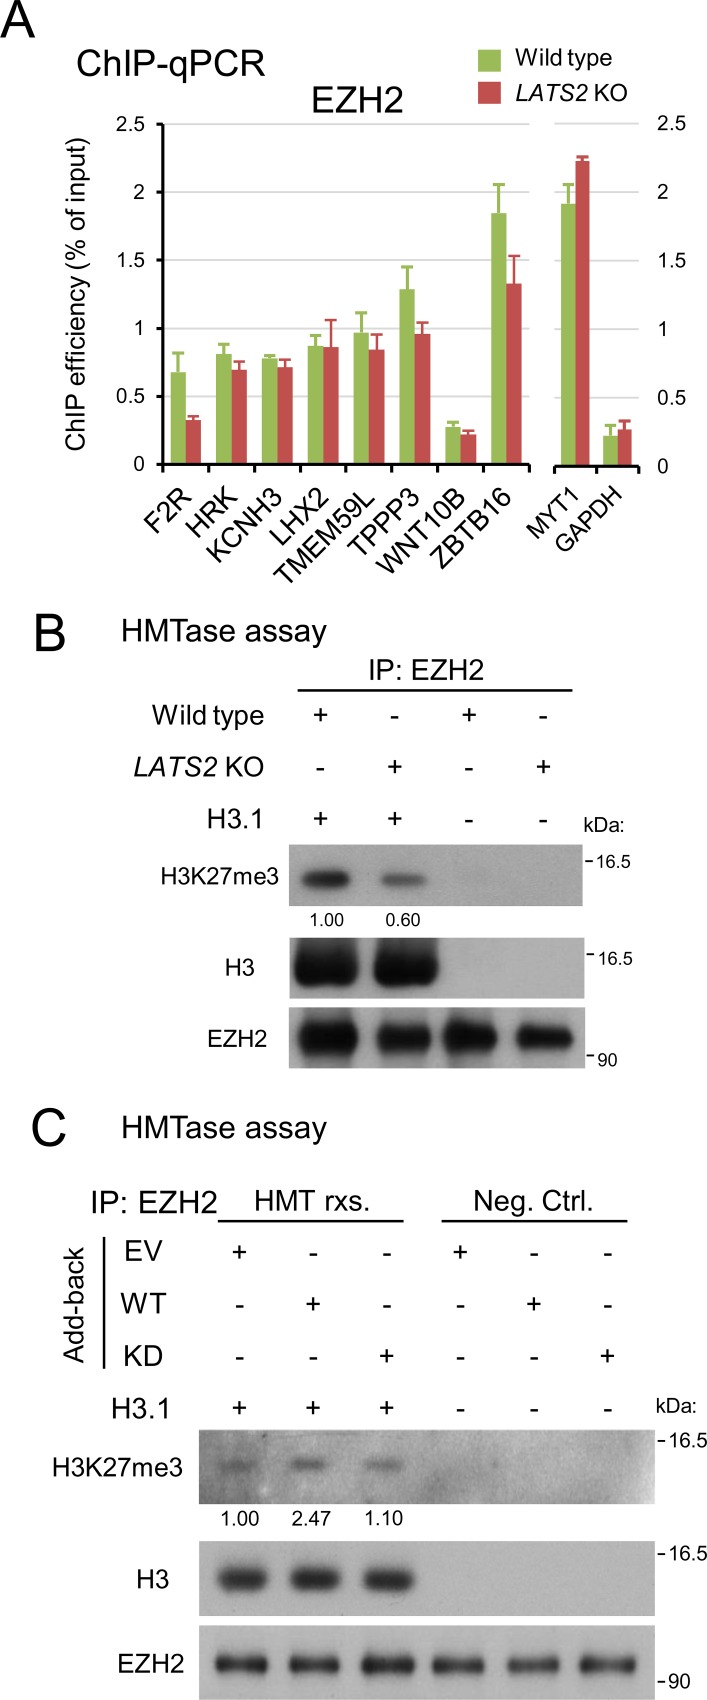
LATS2 affects HMTase activity of PRC2 in kinase dependent fashion.(A) ChIP-qPCR analysis for EZH2 in a series of known PRC2 targets assessed in Fig 2E. The MYT1 locus and GAPDH locus are positive and negative control regions for EZH2, respectively. All ChIP experiments were performed at least twice independently; error bars show SD. (B) In vitro HMTase assay with immunoprecipiated EZH2 of LATS2 KO cells. Endogenous PRC2 was purified by immunoprecipitation of active chromatin fraction of each cell line. The background H3K27me3-level was validated in no-substrate setup. The amount of EZH2 protein in IP-input was titrated beforehand, the equivalent EZH2 between samples was used for HMTase reaction. Each H3K27me3 level was normalized by the signal of immunoprecipitated EZH2. (C) In vitro HMTase assay with immunoprecipiated EZH2 of each add-back cell line. Endogenous PRC2 was purified by immunoprecipitation of active chromatin fraction of each add-back cell line. The background H3K27me3-level was validated in no-substrate setup (Negative control; Neg. Ctrl.), and HMTase activity of each add-back cell line was evaluated by western blotting (HMTase reaction; HMT rxs.). EV, empty vector. WT, kinase active. KD, kinase-inactive mutant. Each H3K27me3 level was normalized by the signal of immunoprecipitated EZH2.